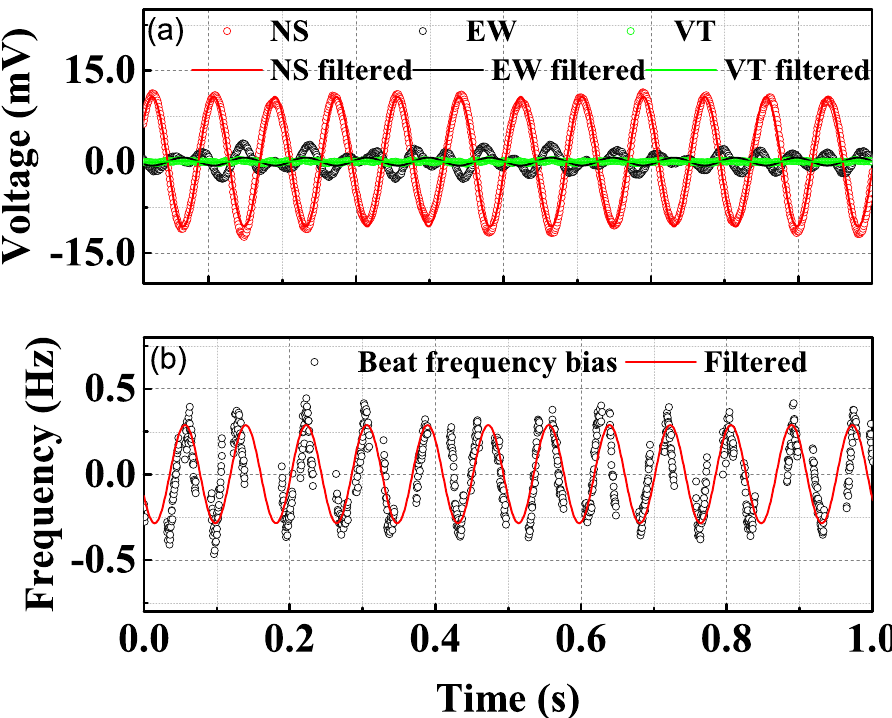
Figure 5. ( a ) Dots are the vibration signal of the cryogenic plate measured by geophones with a 12 Hz vibrational excitation in NS direction, solid curves are the smoothed curves with a 11.5–12.5 Hz bandpass filter. ( b ) Laser frequency bias response to the 12 Hz modulation (dots) and the smoothed curve with the 11.5–12.5 bandpass filter (red